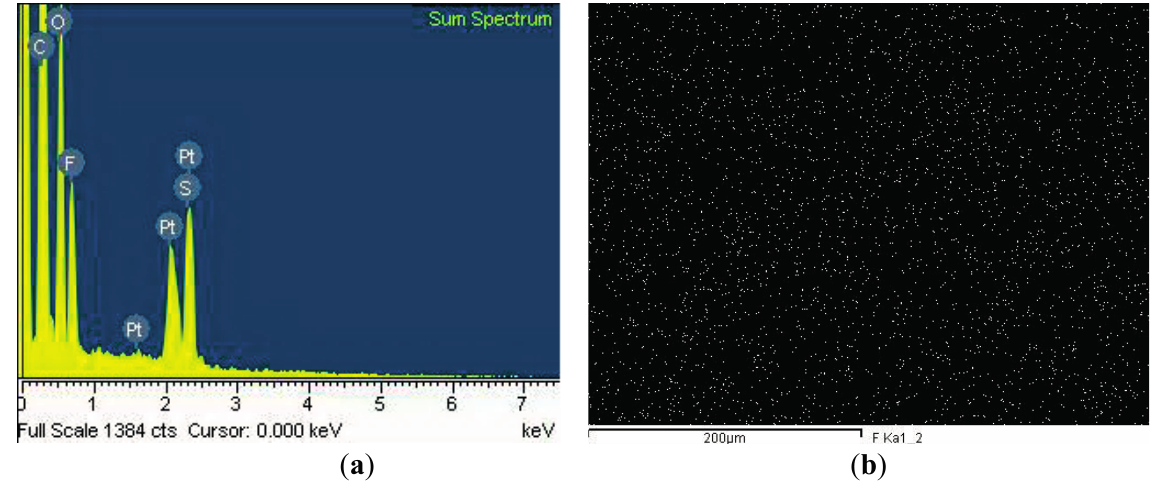
Figure 8. SEM morphology of SPI/PIL composite membranes. ( a ) SPI2fS/V 40 (30,000 magnification) and ( b ) SPI2fS/V 40 after water immersion.